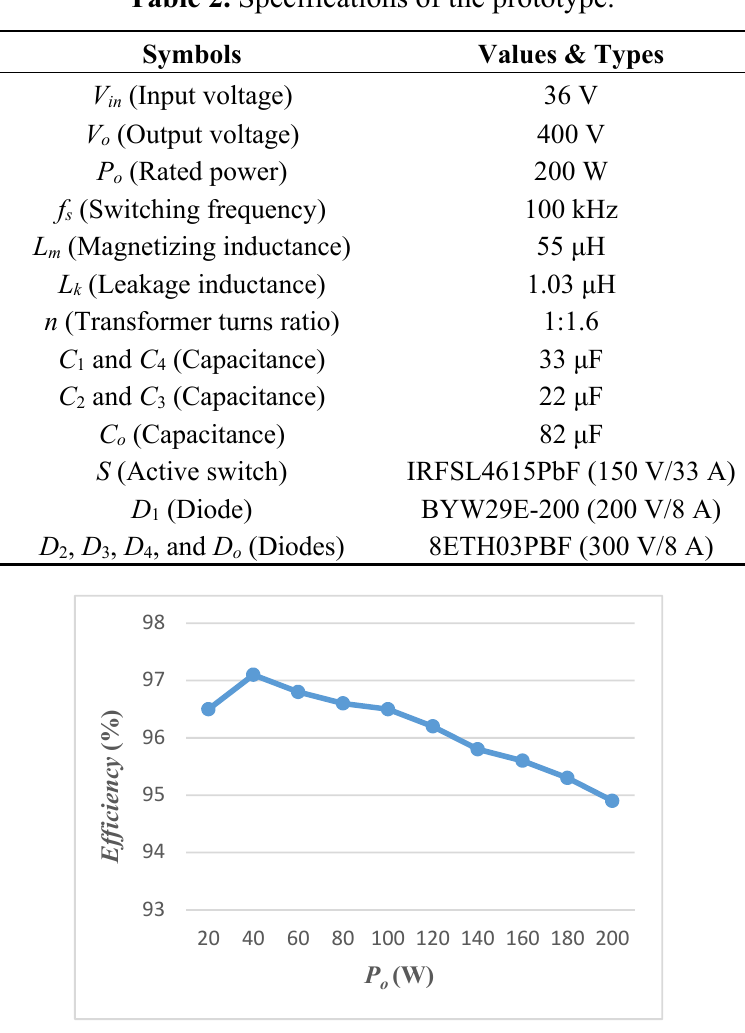
Figure 10. Measured efficiency of the proposed